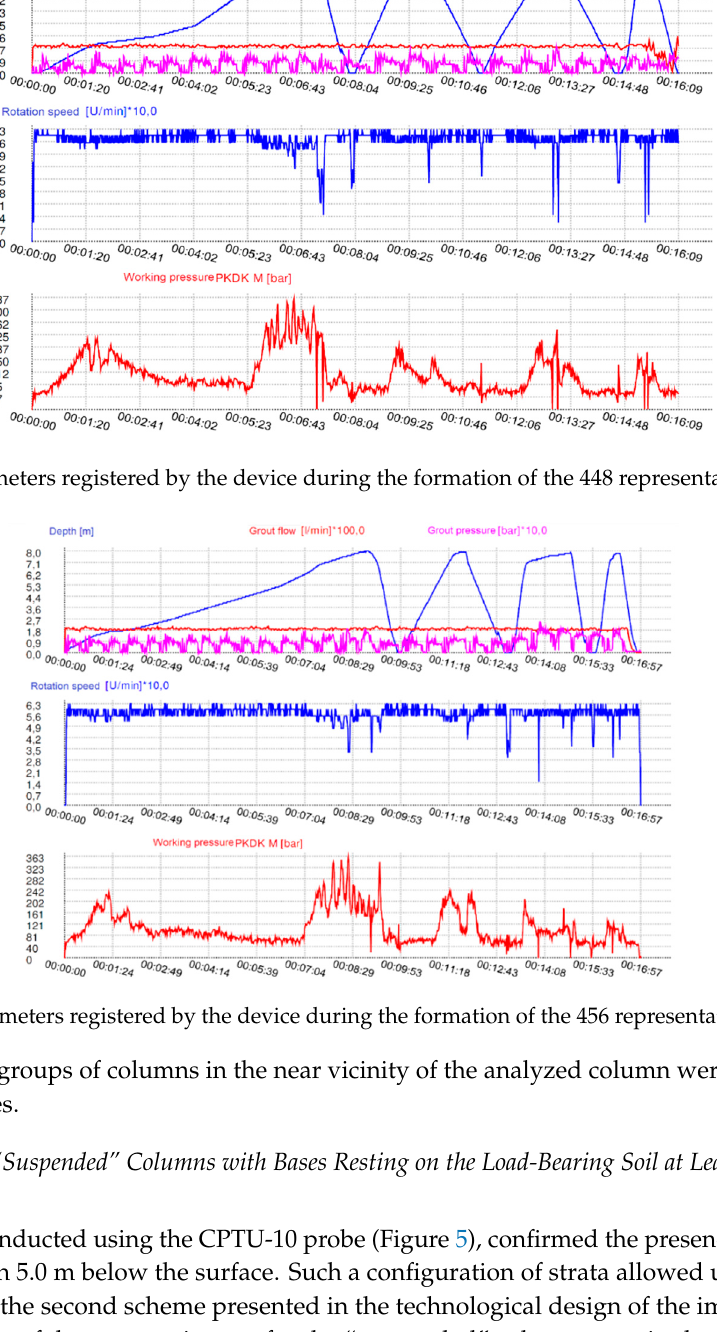
Figure 11. Parameters registered by the device during the formation of the 714 representative columns.